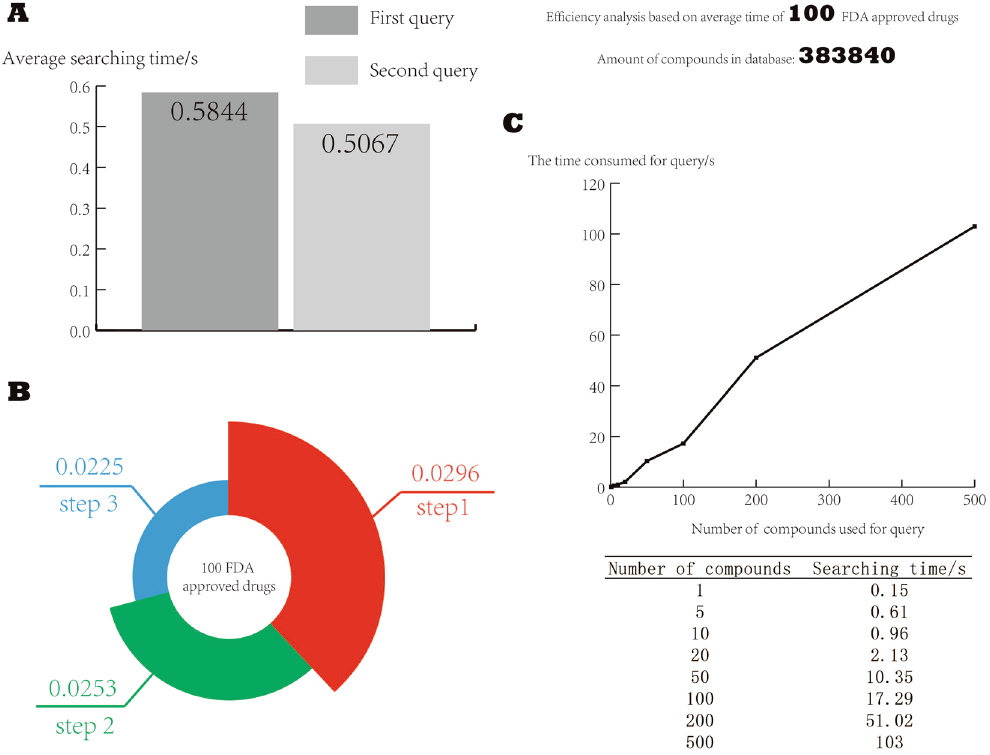
Figure 6. The searching efficiency of the database. ( A ) Time consumed of the first query and the second query; ( B ) Time spent on different steps of the whole process; ( C ) Searching time of searching with different amount of